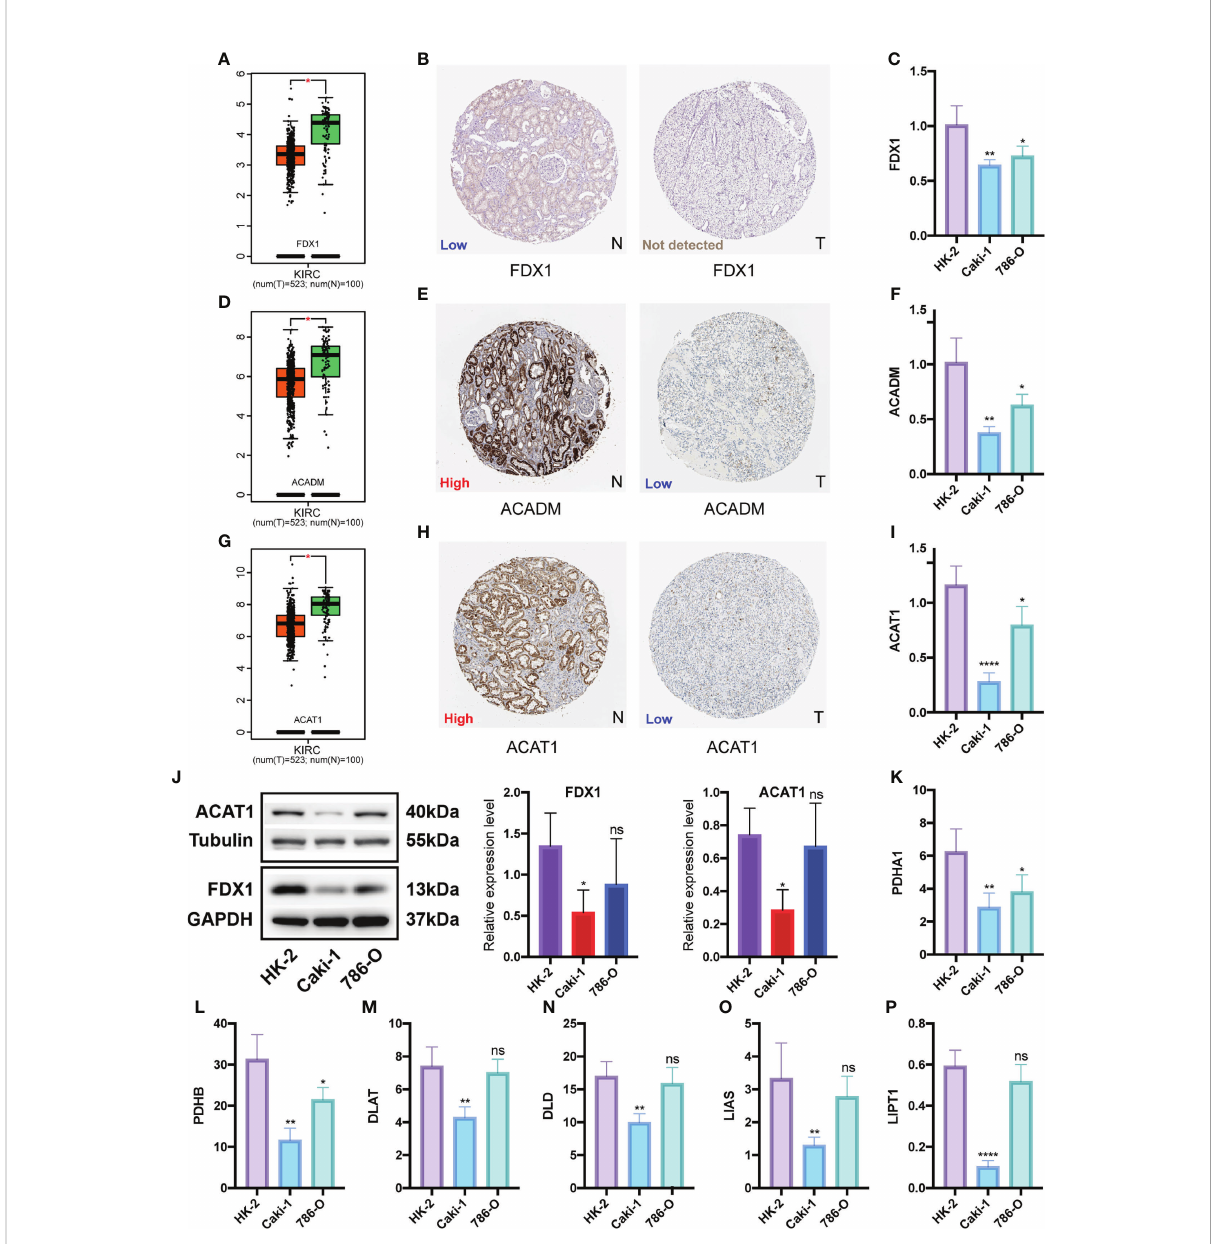
FIGURE 10 Differential expression validation of 7 CPGs and 2 potential CPGs between KIRC and normal samples. GEPIA database was used to compare the expression differences of FDX1 (A) , ACADM (D) and ACAT1 (G) between KIRC and normal kidney tissues. The HPA database showed the expression of FDX1 (B) , ACADM (E) and ACAT1 (H) at the tissue protein level by immunohistochemistry. Western Blot was used to compare the protein levels of FDX1 and ACAT1 in KIRC cells (Caki-1 and 786-0) and normal renal tubular epithelial cells (HK-2), and the results were semi- quanti fi ed by integrated density (J) . qRT-PCR was used to compare mRNA levels of FDX1 (C) , ACADM (F) , ACAT1 (I) , PDHA1 (K) , PDHB (L) , DLAT (M) , DLD (N) , LIAS (O) and LIPT1 (P) in KIRC cells (Caki-1, 786-0) and normal renal tubular epithelial cells (HK-2). CPG, cuproptosis-promoting gene; N, normal; T,tumor; ns, no signi fi cant difference, *p < 0.05, **p < 0.01, and ****p < 0.0001. Western Blot data are means ± SD, with n = 3; qRT-PCR data are means ± SD, with n =